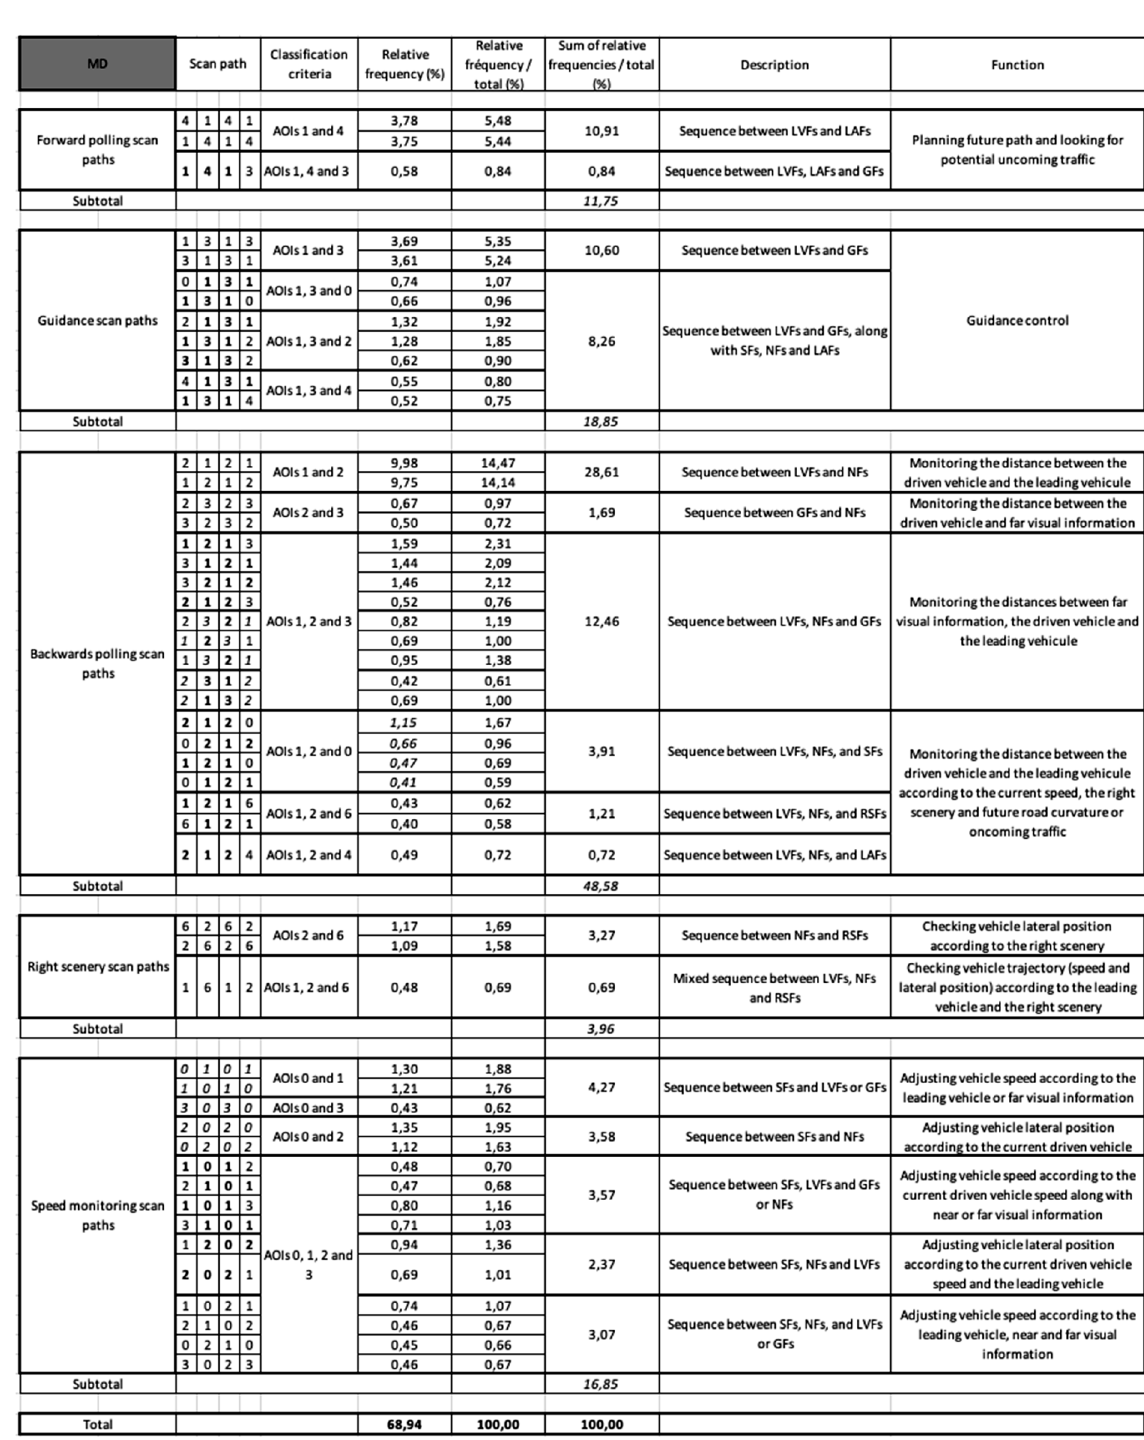
Table 1. The fifty most frequent scan paths (length 4) out of the 351 scan paths observed in Manual Driving (MD). Given are each scan paths relative frequency (%) in the entire dataset, and relative frequency for the subset of the 50 scan paths analyzed (%) along with a description of the associated visual sequence and proposed functional interpretations. LVFs: Leading Vehicle Fixations; RSFs: Right Scenery Fixations; SFs: